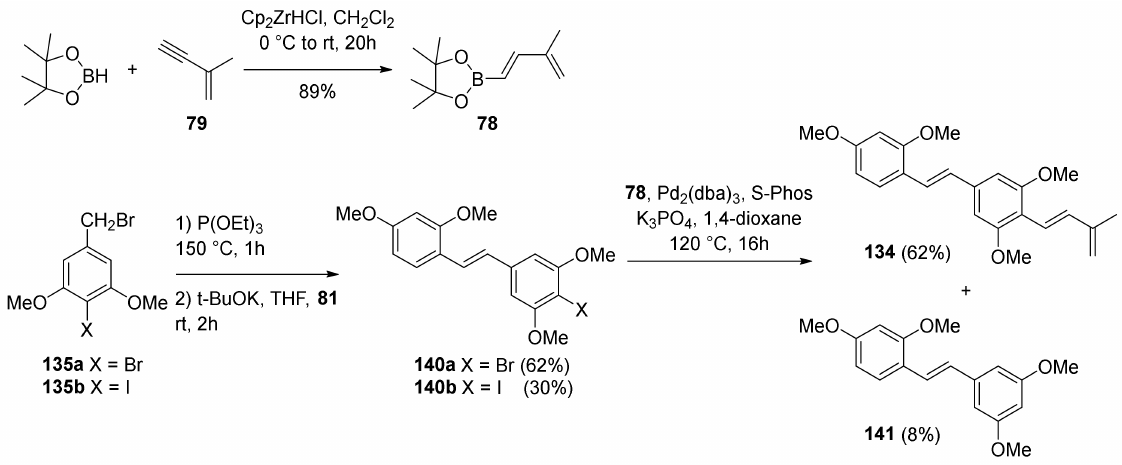
Figure 46. Synthesis of diene 134